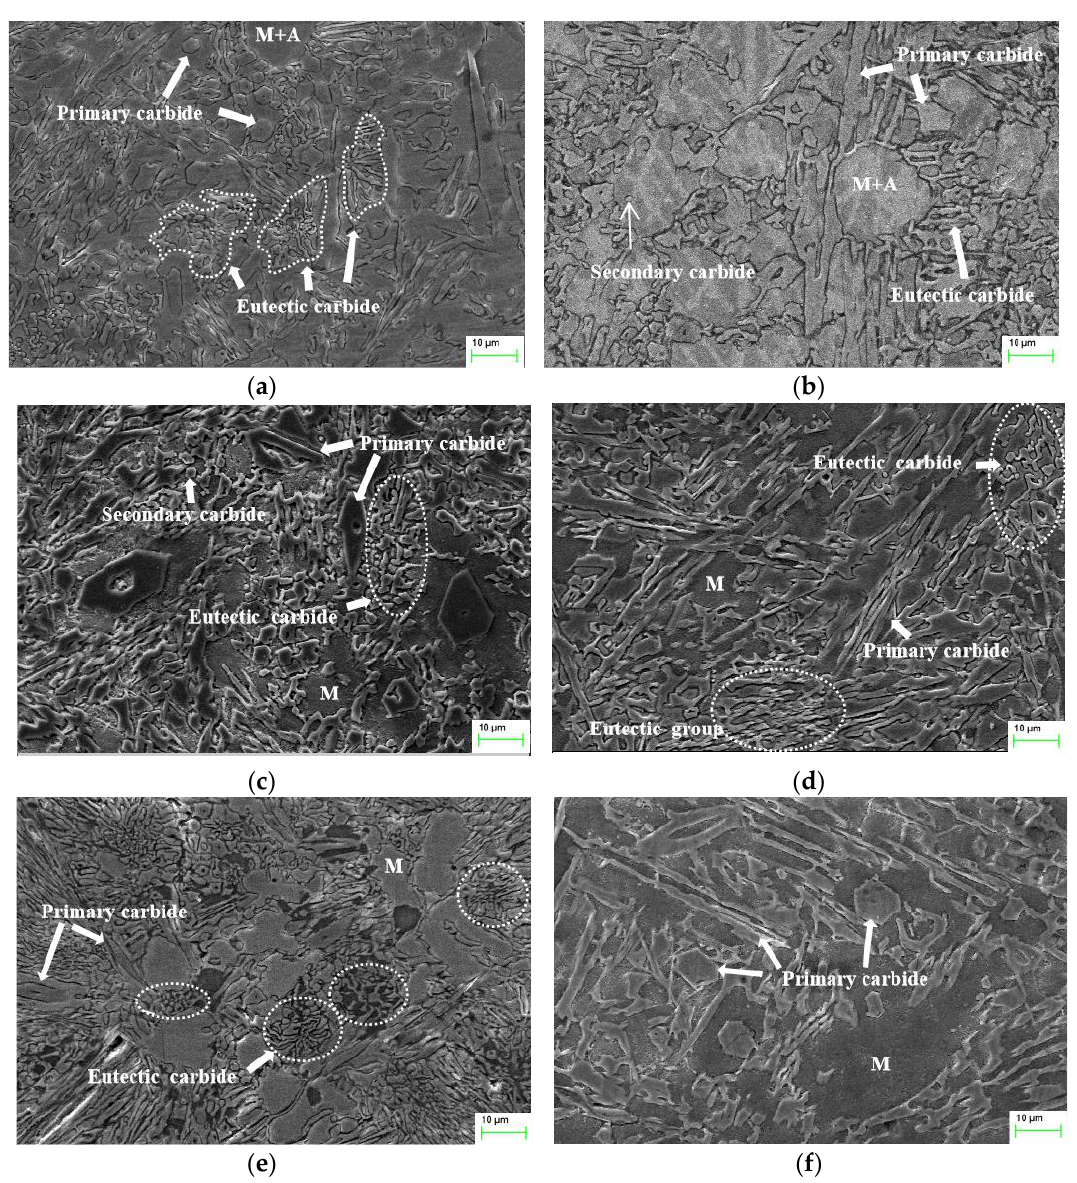
Figure 4. SEM micrographs of the control group and the five groups after subcritical quenching at different temperatures: ( a ) without heat treatment; ( b ) 500 °C-quenching; ( c ) 530 °C-quenching; ( d ) 550 °C-quenching; ( e ) 580 °C-quenching; ( f ) 630 °C-quenching.